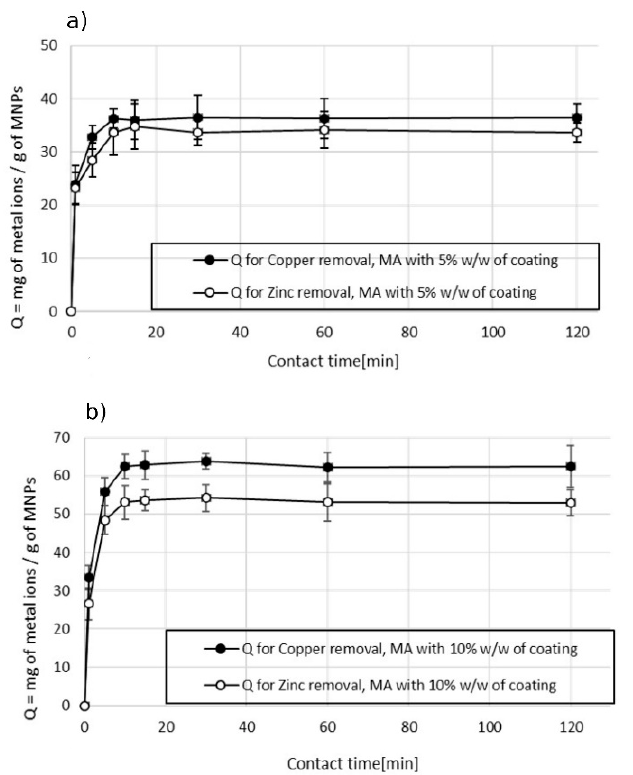
Figure 9. Effect of contact time on the adsorption capacity in the removal of Cu 2+ and Zn 2+ . ( a ) MA with 5% w/w coating and ( b ) MA with 10% w/w coating, pH 7.2.